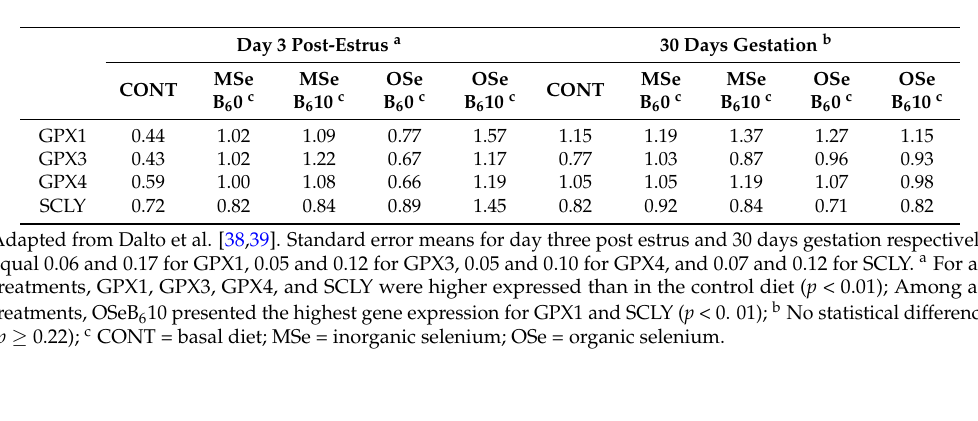
Table 1. Real-time mRNA abundance of liver glutathione peroxidase (GPX) and selenocysteine-lyase (SCLY) genes in gilts three days after the fourth estrus and at day 30 of gestation, according to selenium and vitamin B 6